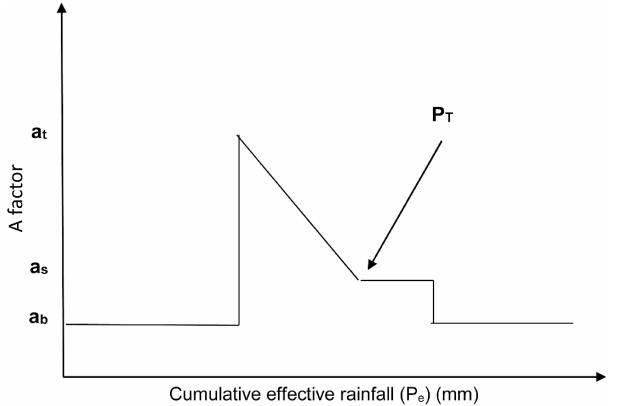
Figure 1. Relationship between sediment concentrations and cu- mulative effective